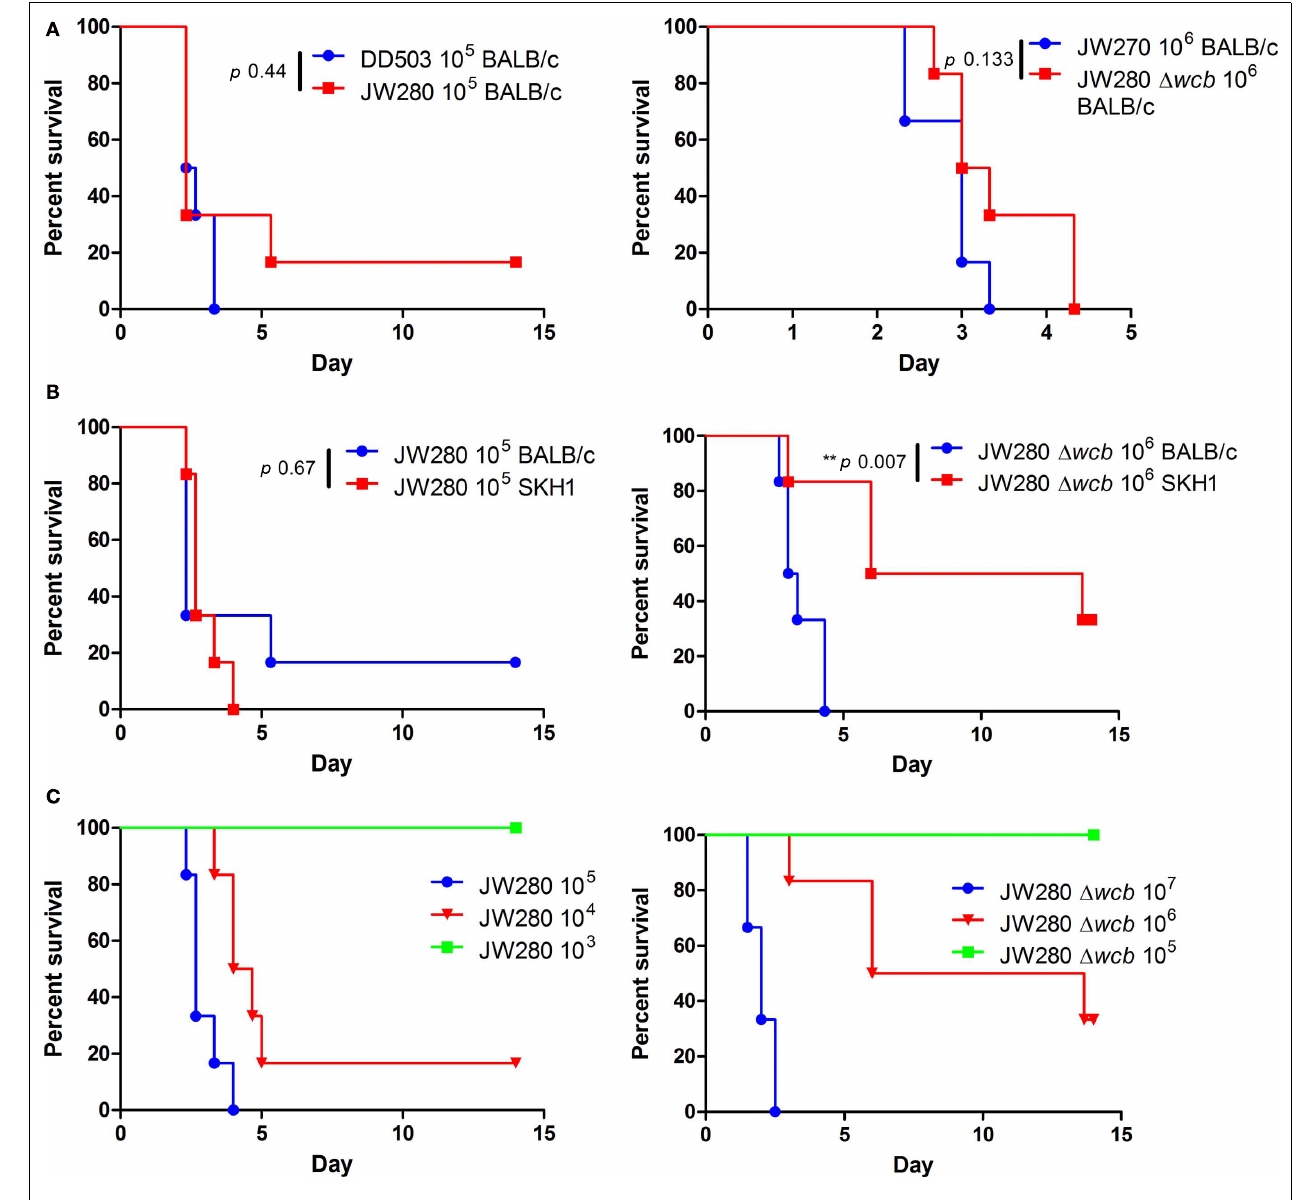
JW280 (cid:2) wcb (right panel) to compare the susceptibility of each mouse strain to melioidosis. (C) SKH1 mice were infected with 3- to 10-fold serial dilutions of JW280 (10 3 –10 5 CFU, left panel) or JW280 (cid:2) wcb (10 5 –10 7 CFU, right panel) to facilitate estimation of the ID 50 for each strain. Mice were euthanized at the onset of moribund disease. Asterisks indicate significant differences between survival curves using the log-rank (Mantel–Cox)